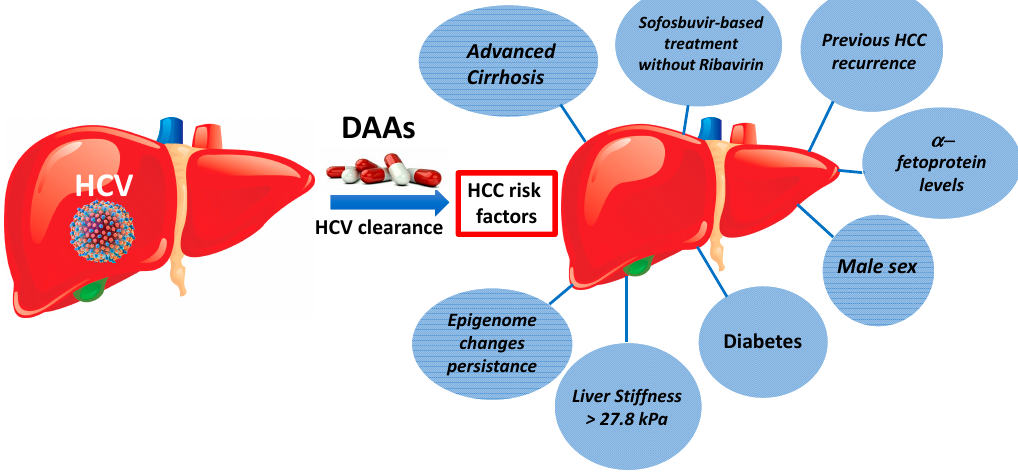
Figure 1. Risk factors of occurrence or recurrence of HCC after HCV clearance by DAAs